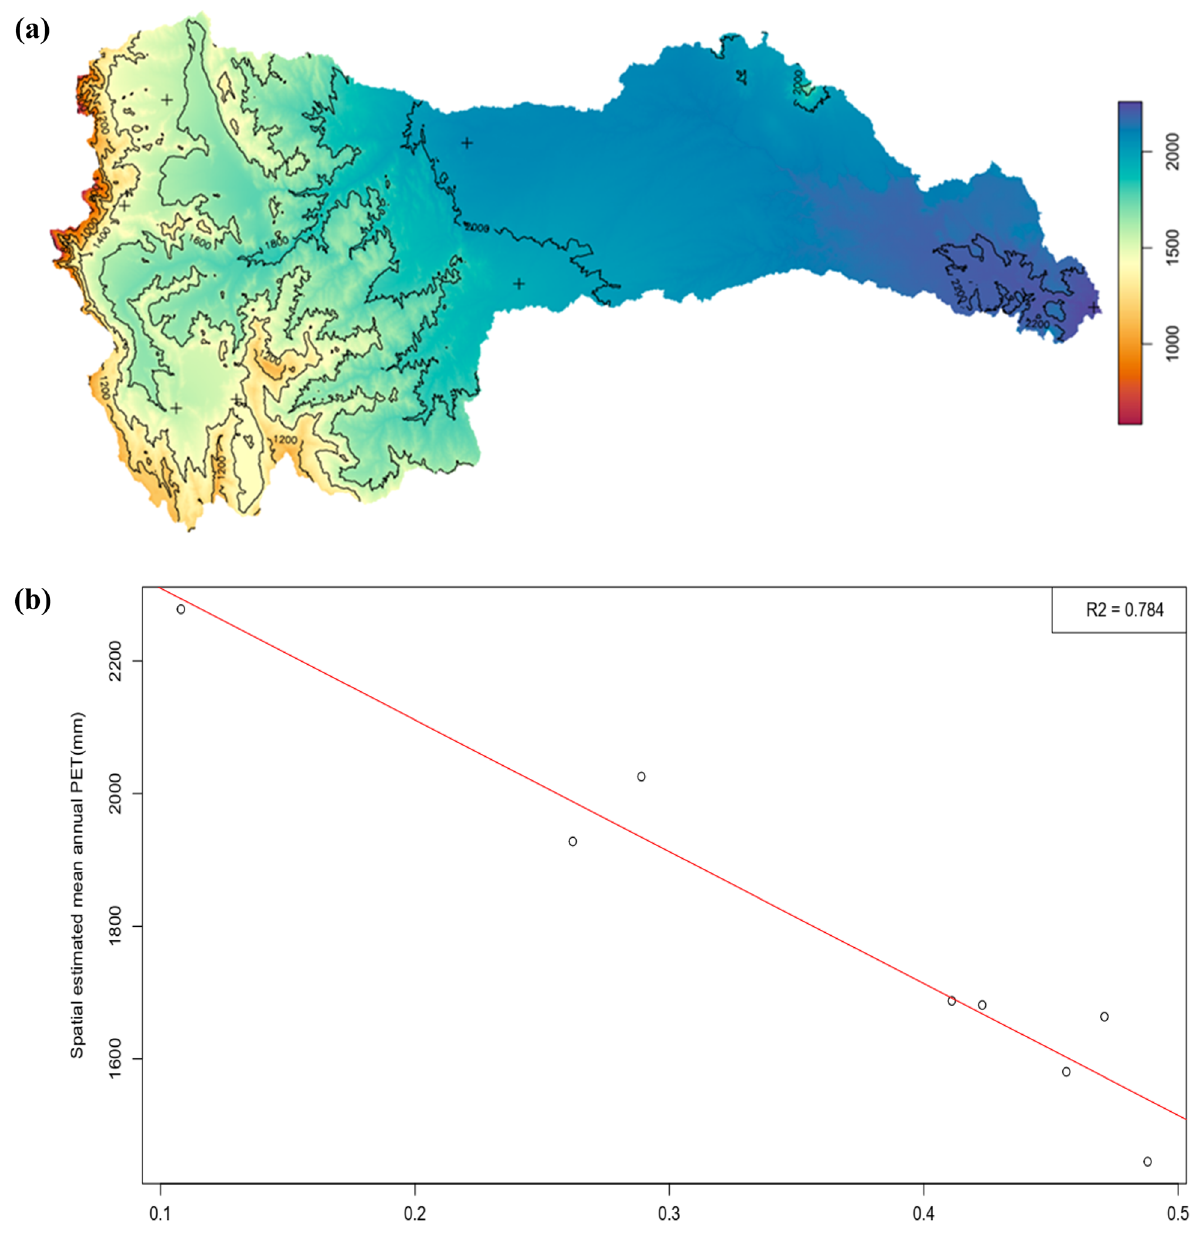
Fig. 8 Spatial patterns of observed mean annual PET in Mille catchment during 1983–2002 a and scatterplot between the observed PET and the land use land cover mean annual NDVI at the catchment scale b . As depicted in Fig. 8a, the mean annual PET is elevated from the head of the catchment to the lower part of the